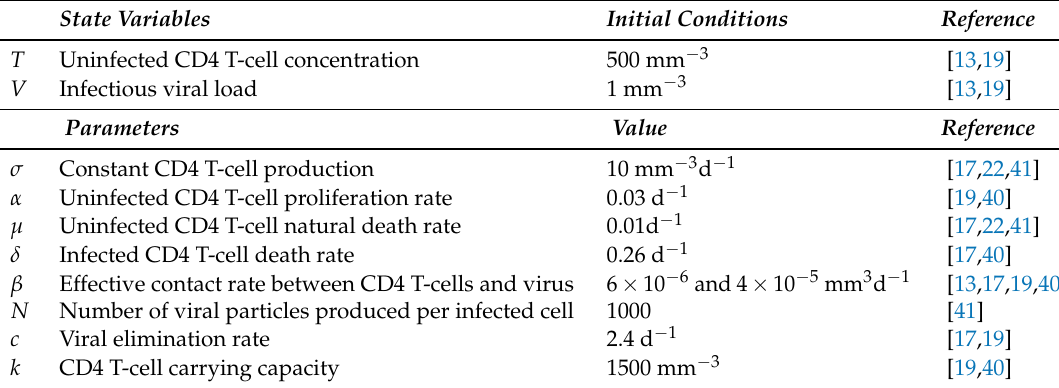
Table 1. Description of state variables, initial conditions, and parameters used in simulations and the respective